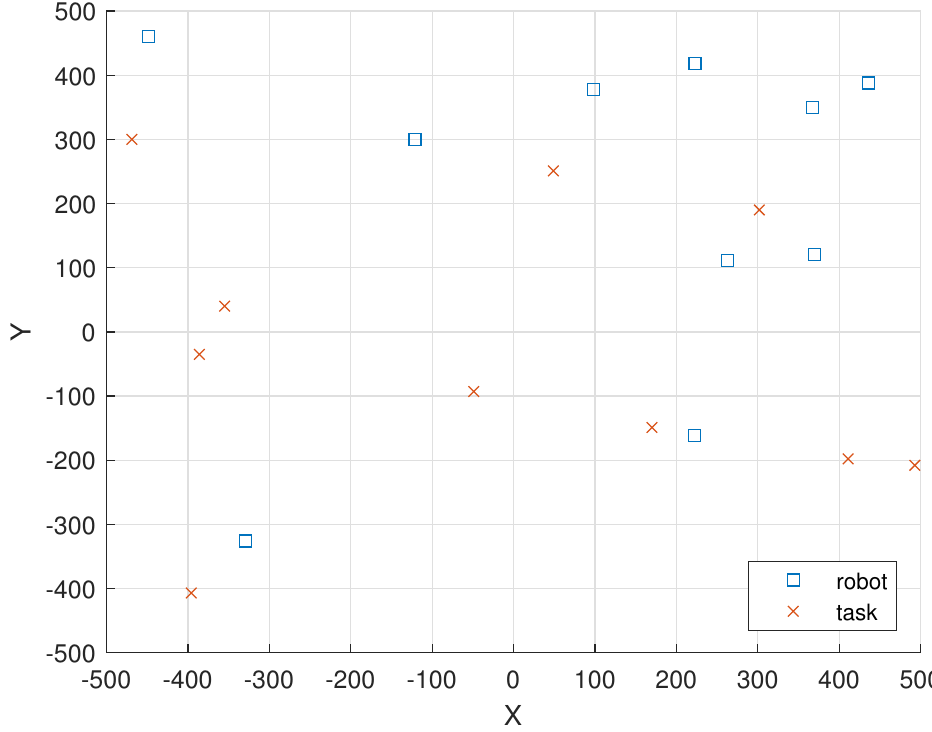
Figure 4. The locations of the 10 i.i.d. EH robot nodes and the locations of the 10 tasks are represented as “square” and “cross” markers,